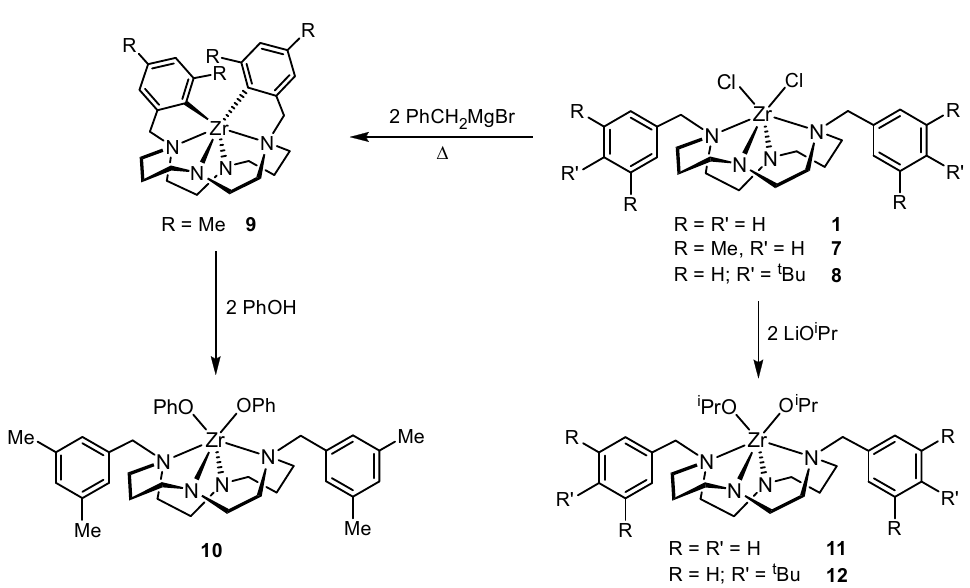
Scheme 2. Synthetic route for the preparation of complexes 10 – 12 .